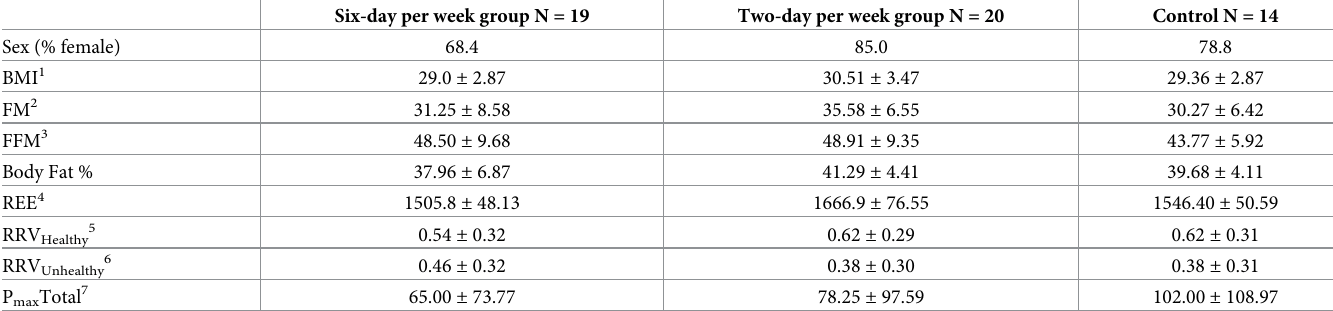
Table 2. Demographics, body composition, and food reinforcement measures for all randomized participants at baseline. Six-day per week group N =